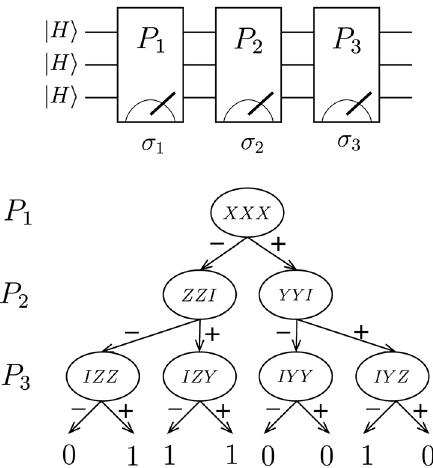
FIG. 1. Example of a PBC on n ¼ 3 qubits. Each step t involves an eigenvalue measurement of a Pauli operator P on n qubits t 1 . A choice of P with an outcome σ may depend on the t ¼ (cid:2) t outcomes of all previous measurements. A PBC on n qubits can be described by a binary tree T of height n such that internal nodes of T are labeled by n -qubit Pauli operators and leaves of T are labeled by 0 and 1. The latter represent the final output bit b . We require that the label of any leaf node can be computed in out time poly ð n Þ on a classical